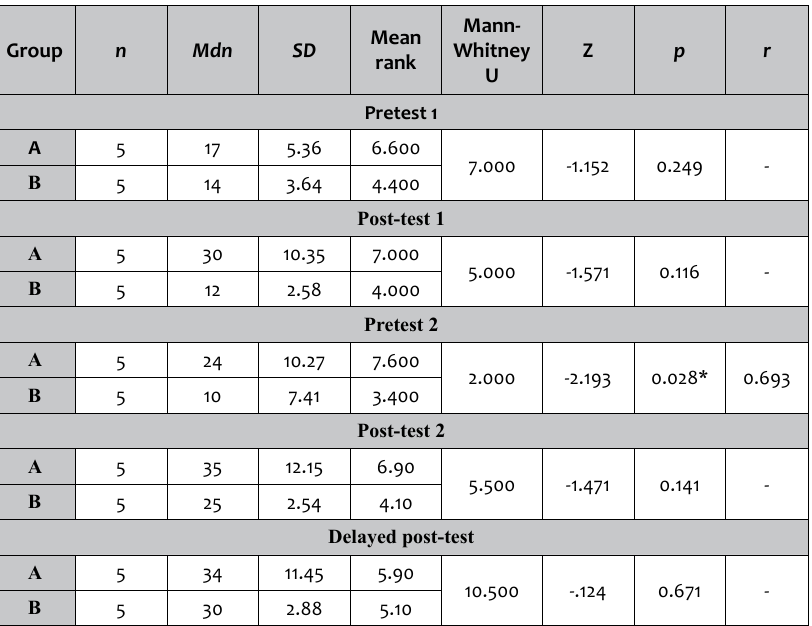
Table 1: Differences between test results for experimental group A and B Group n Mdn SD